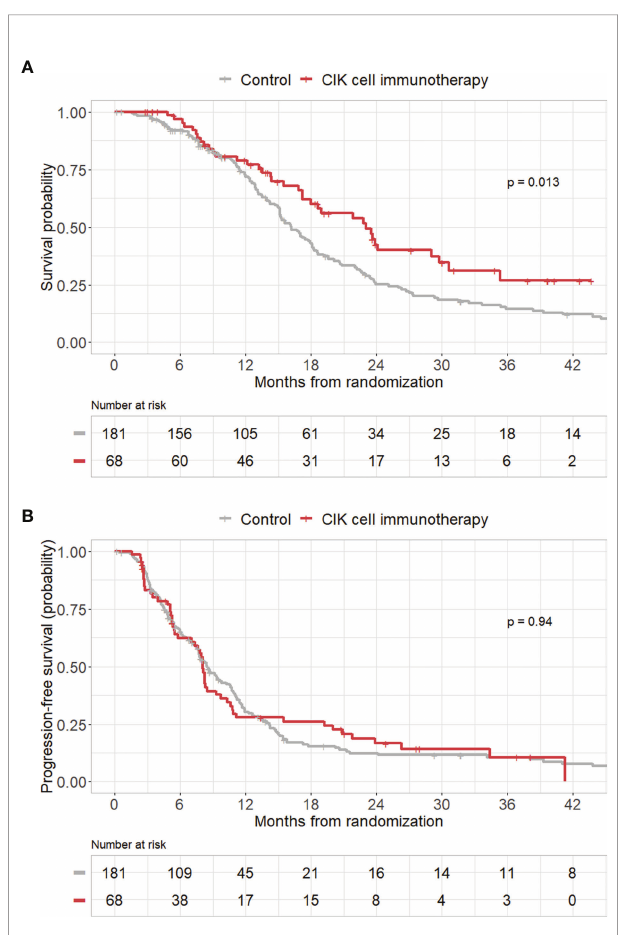
FIGURE 3 | Kaplan – Meier curves of overall survival (OS) and progression- free survival (PFS) rates according to CIK immunotherapy in the mITT population with pathologically pure GBM with the TCGA cohort as the control group. (A) OS rate according to CIK immunotherapy for patients with pure GBM in the mITT population with the TCGA cohort as the control group. (B) PFS rate according to CIK immunotherapy for patients with pure GBM in the mITT population with the TCGA cohort as the control